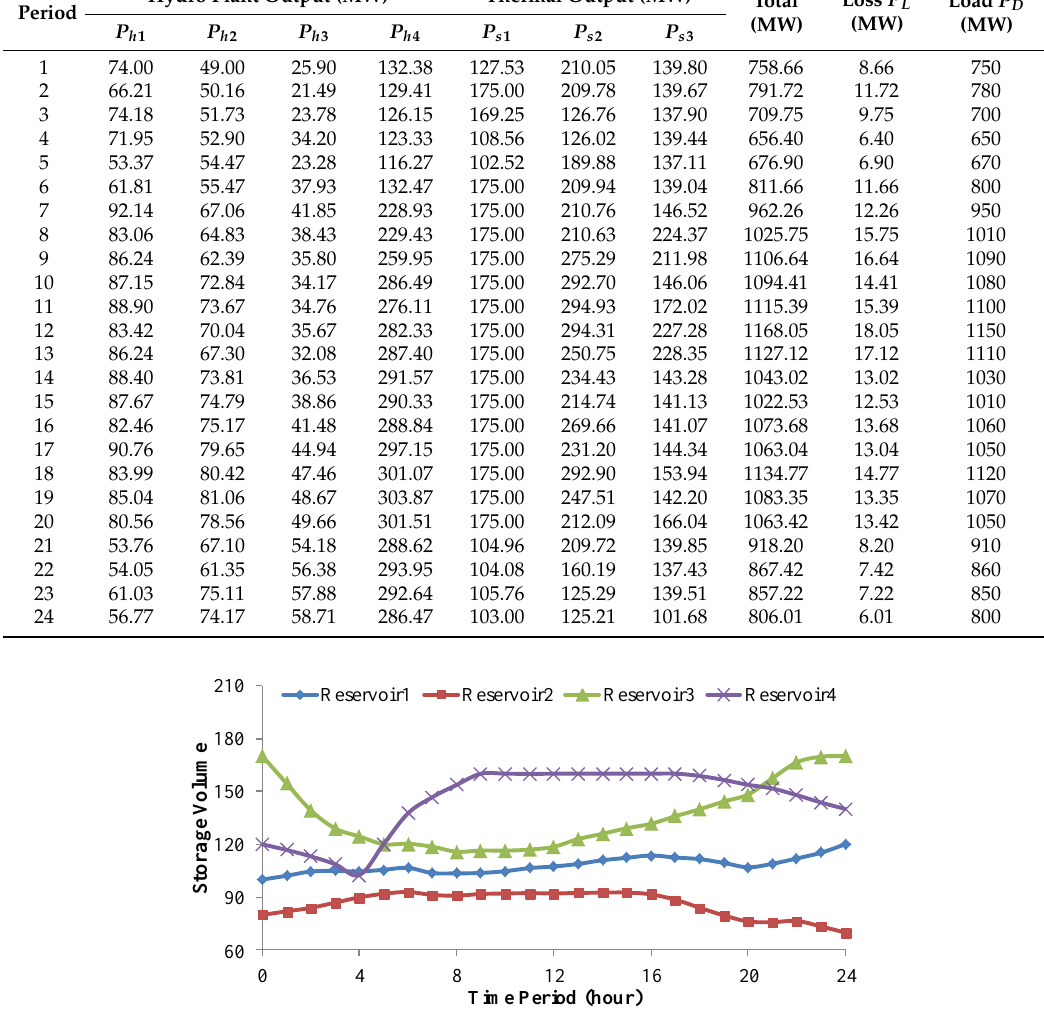
Figure 12. The water storage processes of Scheme 15 by PMOGA for Case 3.